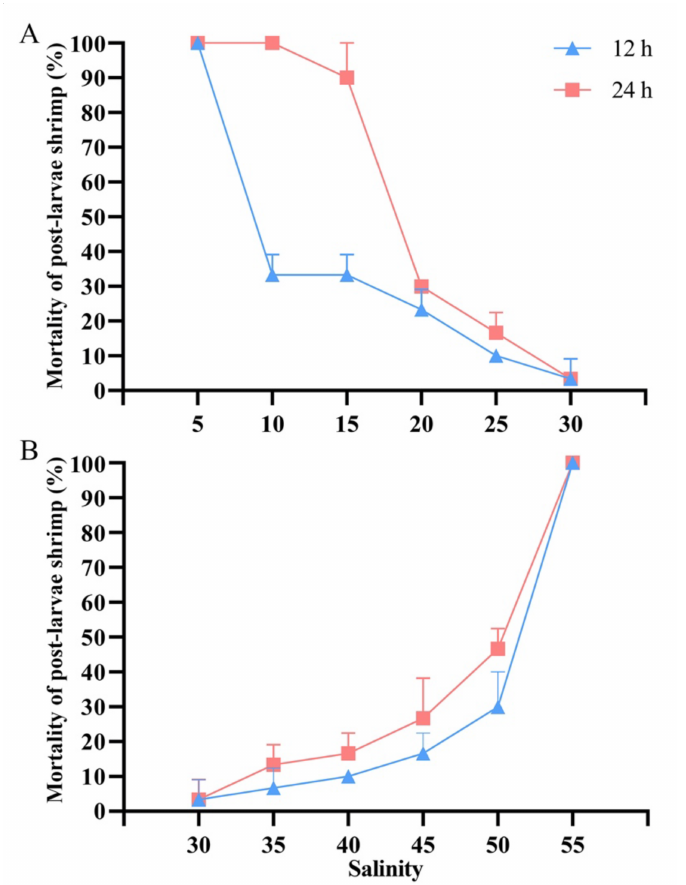
Figure 3. Cumulative mortality rates of post-larvae shrimp under acute ( A ) low-salinity and ( B ) high- salinity stress. Each bar represents the mean value from three repetitions with